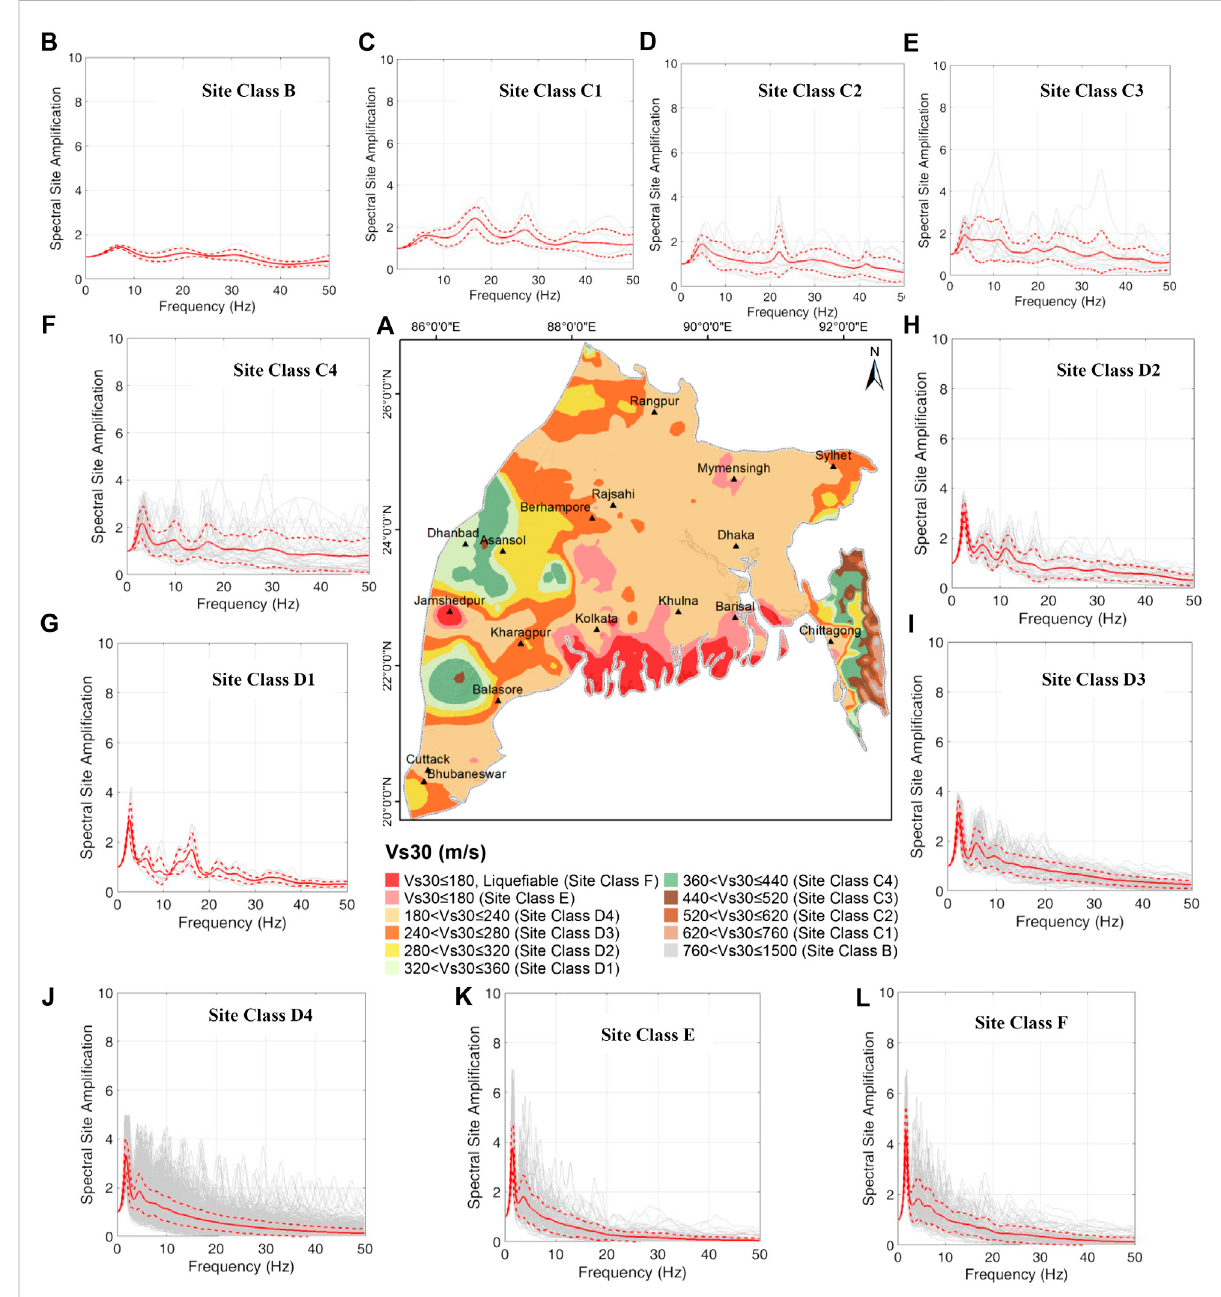
FIGURE 11 (A) Siteclassi fi cationmapofBengalBasinadheringtoSunetal.(2018)anddisplayingthepresenceofsiteclassesF,E,D4,D3,D2,D1,C4,C3,C2, C1, and B in the terrain with the dominance of site class D4 followed by site class D3 and site class E in this alluvial fi eld region, while site classes C4, C3,C2,C1,andBareinthehillyterrain.Thegenericsiteampli fi cationspectrumforsiteclasses (B) B, (C) C1, (D) C2, (E) C3, (F) C4, (G) D1, (H) D2, (I) D3, (J) D4, (K) E, and (L) F with spectral ampli fi cations of 1.45 at 6.7 Hz, 1.6 at 6.3 Hz, 1.89 at 4.7 Hz, 1.92 at 3.36 Hz, 2.19 at 3.12 Hz, 2.9 at 2.68 Hz, 3.06 at 2.53 Hz, 3.17 at 2.24 Hz, 3.31 at 1.8 Hz, 3.75 at 1.7 Hz, and 4.5 at 1.47 Hz,